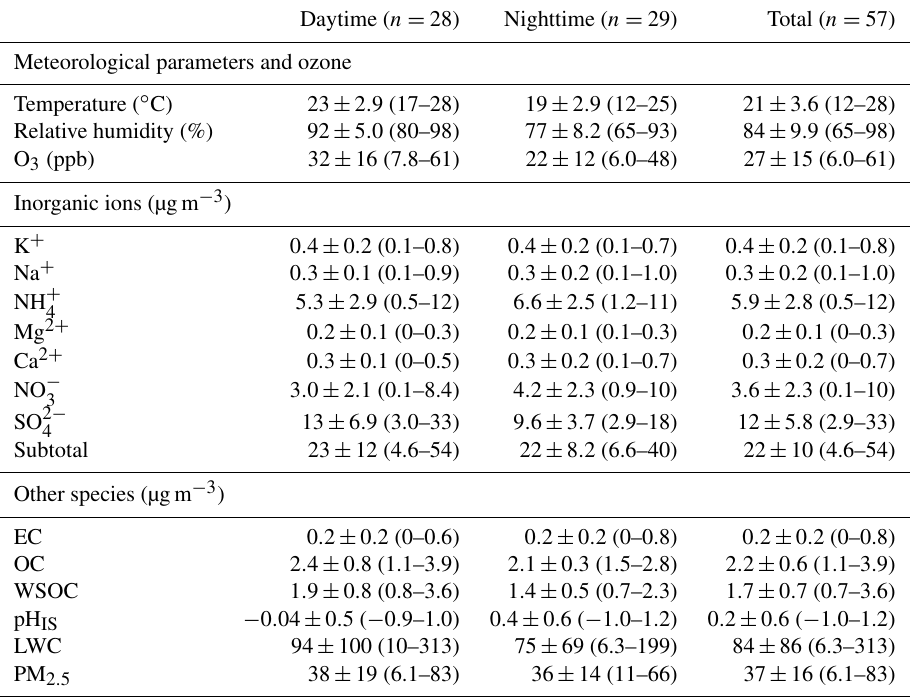
Table 1. Meteorological parameters and concentrations of inorganic ions, ozone, water soluble organic carbon (WSOC), organic carbon (OC), elemental carbon (EC), liquid water content (LWC) and in situ pH (pH IS ) of PM 2 . 5 from Mt. Tai in the